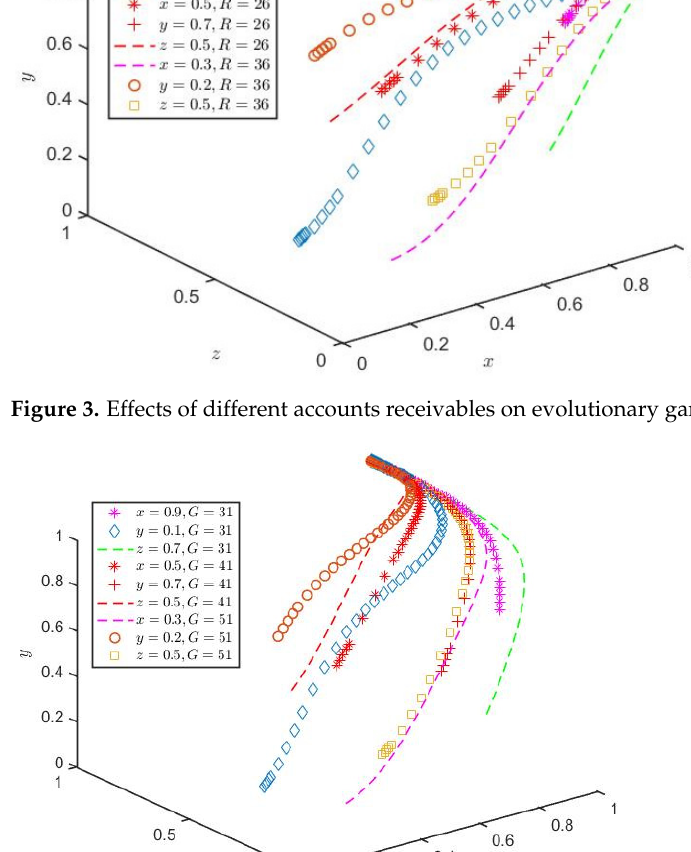
Figure 4. Effects of different trustworthy incentive incomes on evolutionary game strategies.